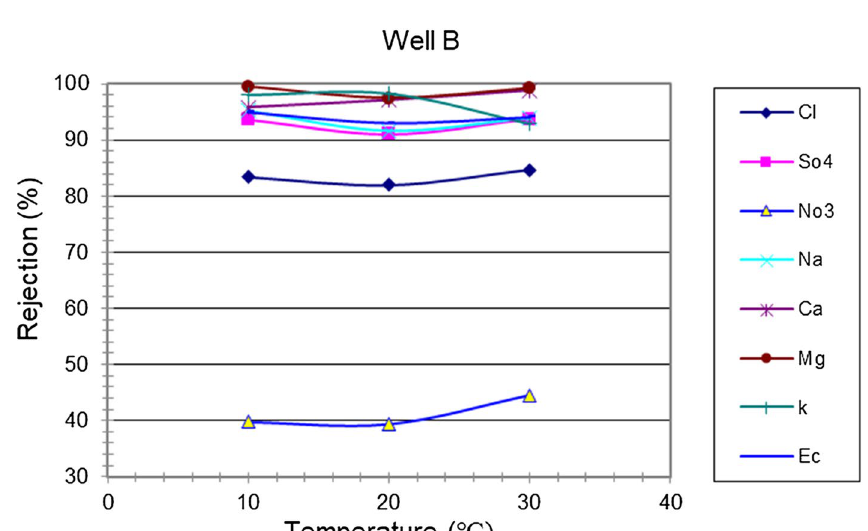
Fig. 9, at a pressure of 8 bar, the rejection values of Cl − ,